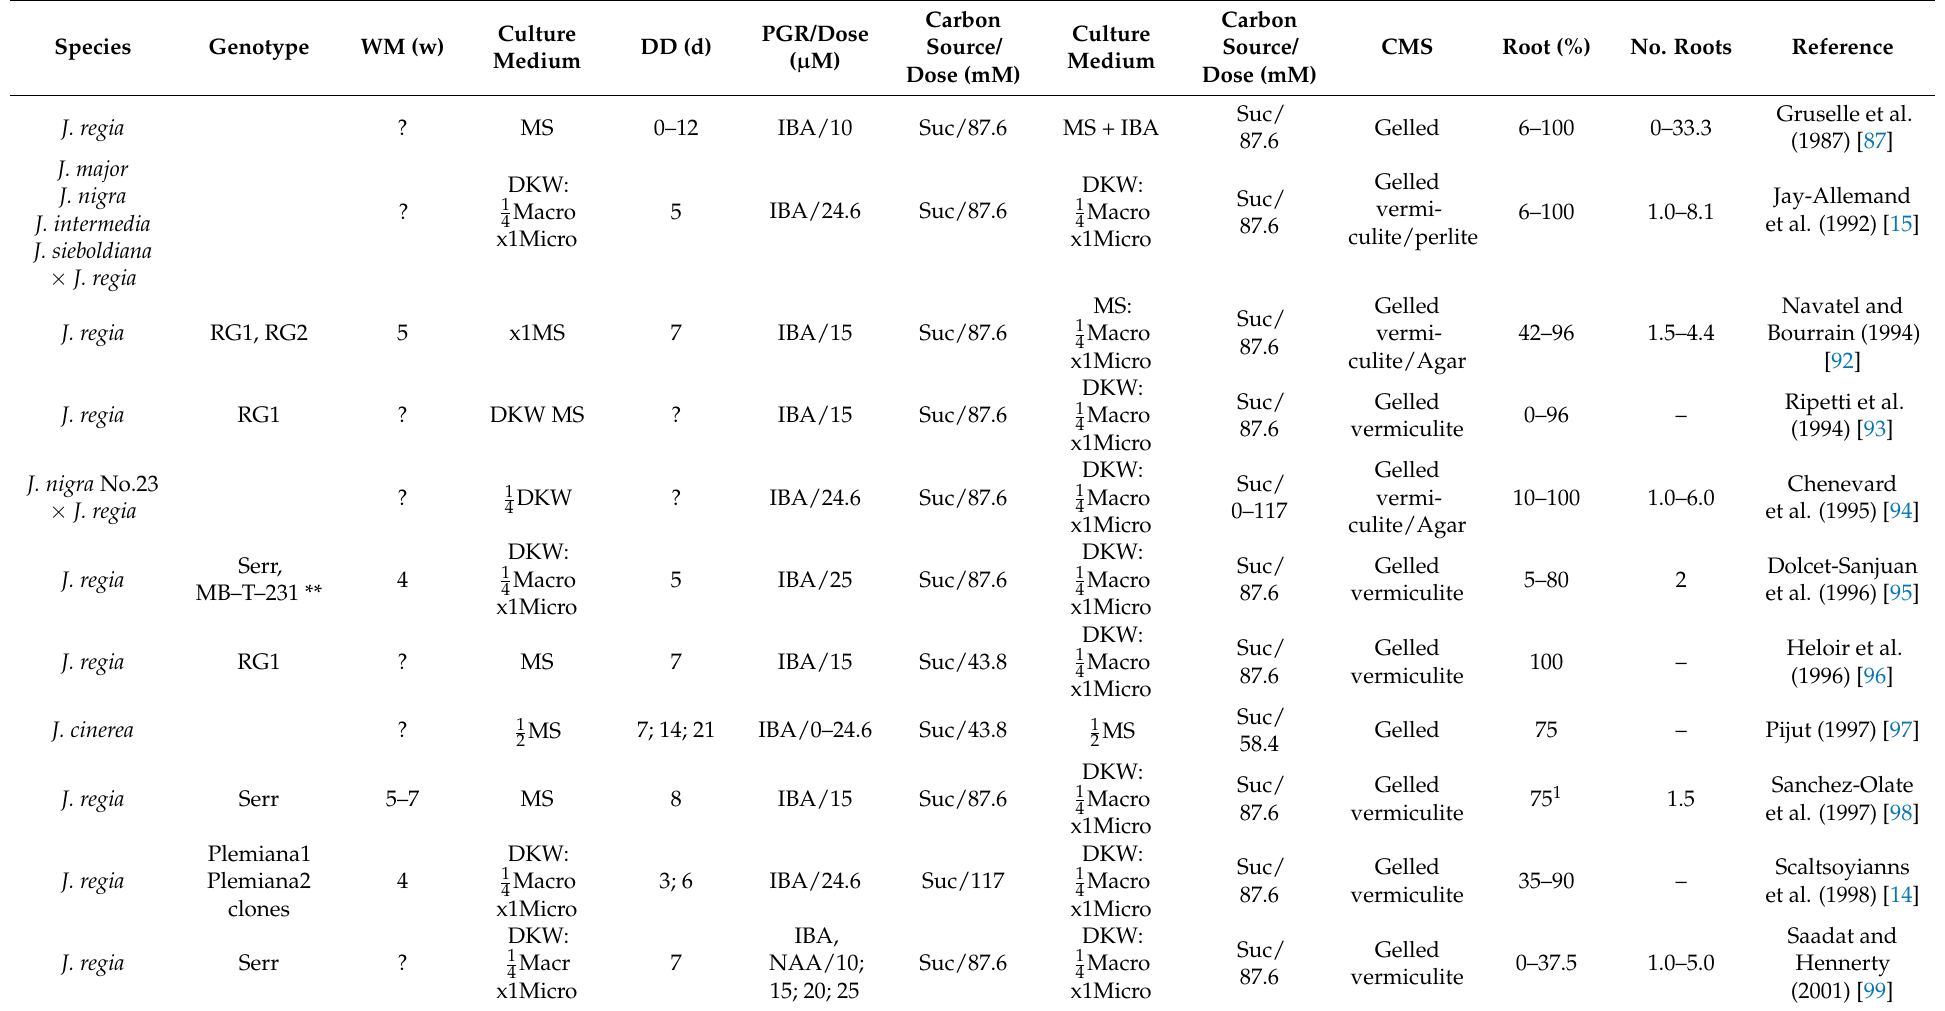
Table 1. In vitro rooting procedures used for walnut species and hybrids, including dark (pre-induction) and light (root expression) phases.